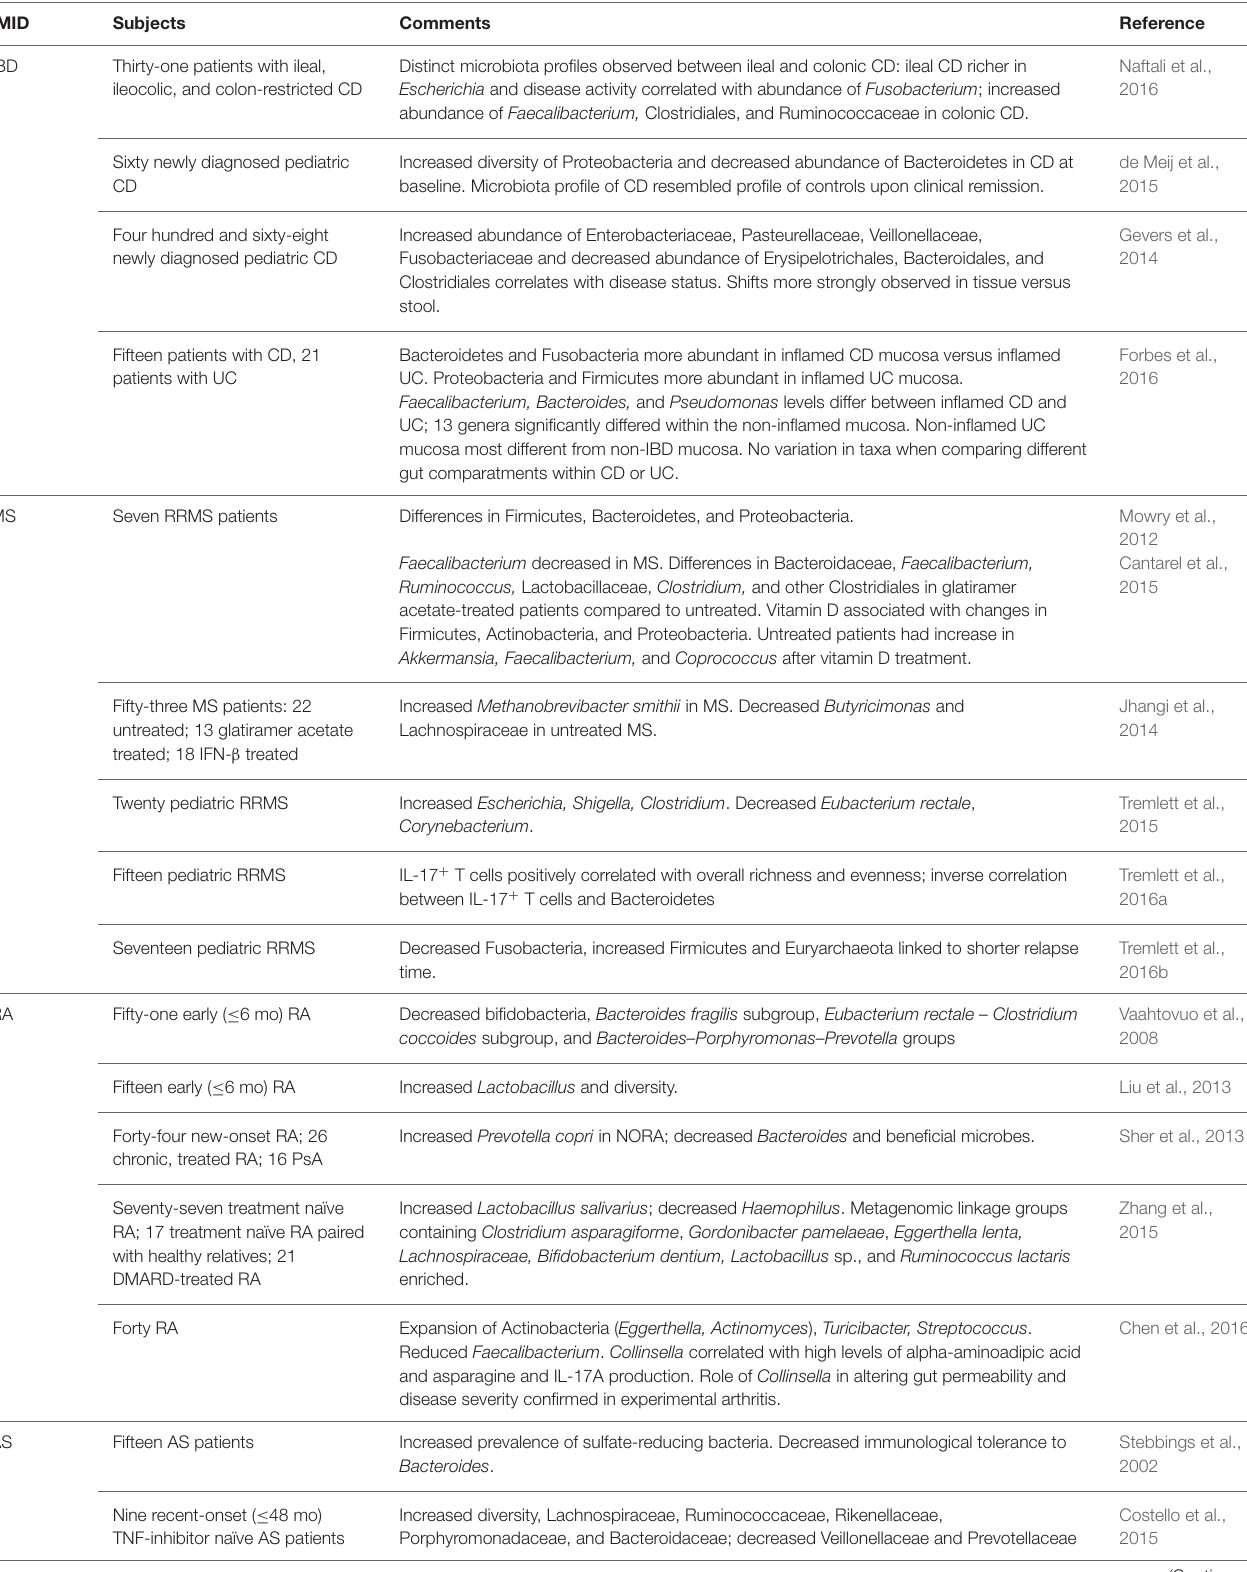
TABLE 1 | Current studies investigating the role of the gut microbiota in IMID patients. IMID